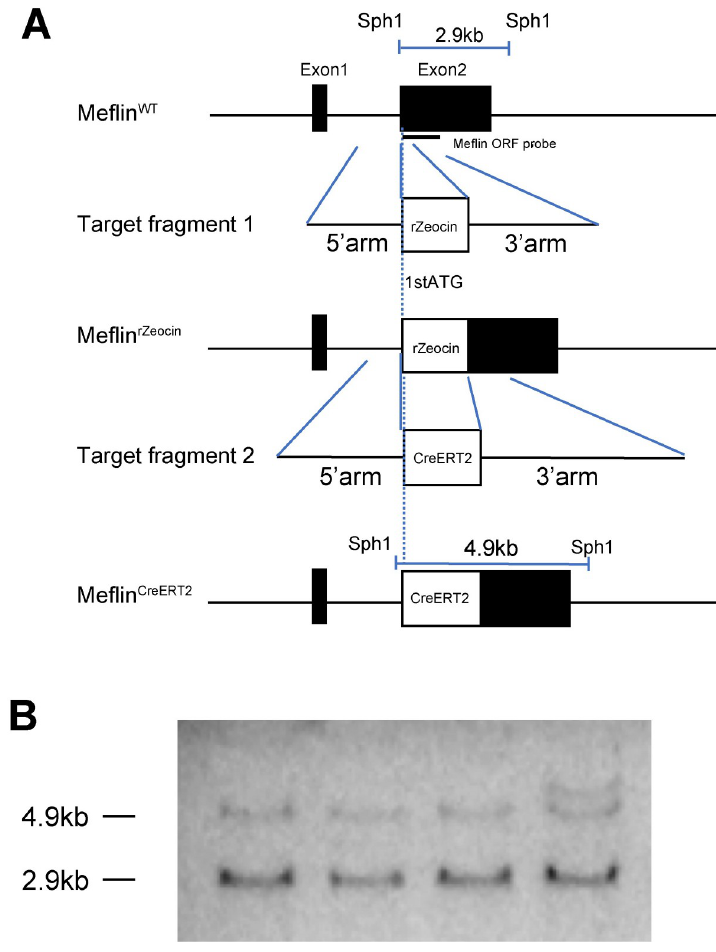
Fig 1. Generation Meflin-CreER T2 mice. a) First, BAC carrying the Meflin gene was introduced together with a zeocin resistance gene ( rZeocin ) downstream of the translation start point Met. Next, counter-selection using a CreER T2 fragment with the 5’ and 3’ homologous arms of the Meflin gene was performed. b) Southern blot analysis. Genomic DNA was digested with Sph1 and detected using a Meflin -ORF probe. The transgenic allele was identified at 4.9 kb, and the wild-type allele was identified at 2.9